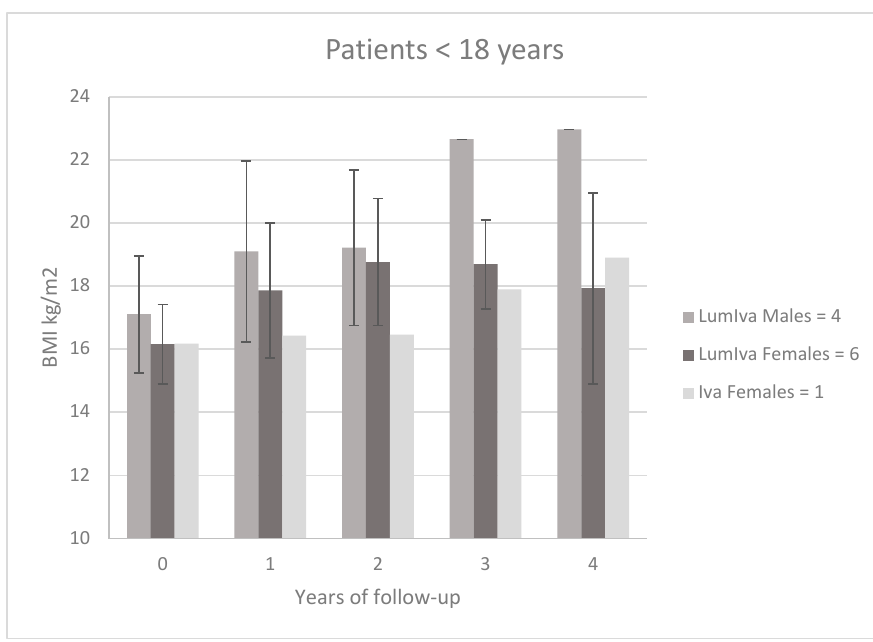
Figure 1. BMI trend (mean ± SD) in 4 males and 6 females aged between 2–18 years treated with LumIva and one female treated with Iva.